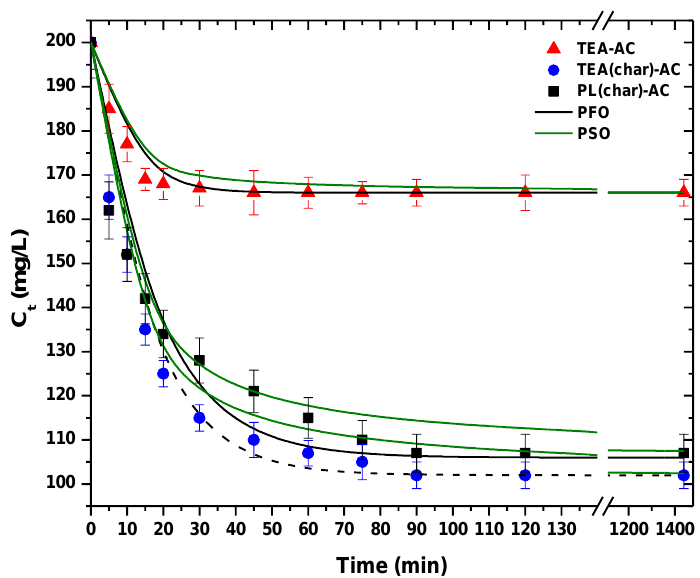
Figure 8. Kinetic curves for PRM adsorption onto the synthesized AC samples.